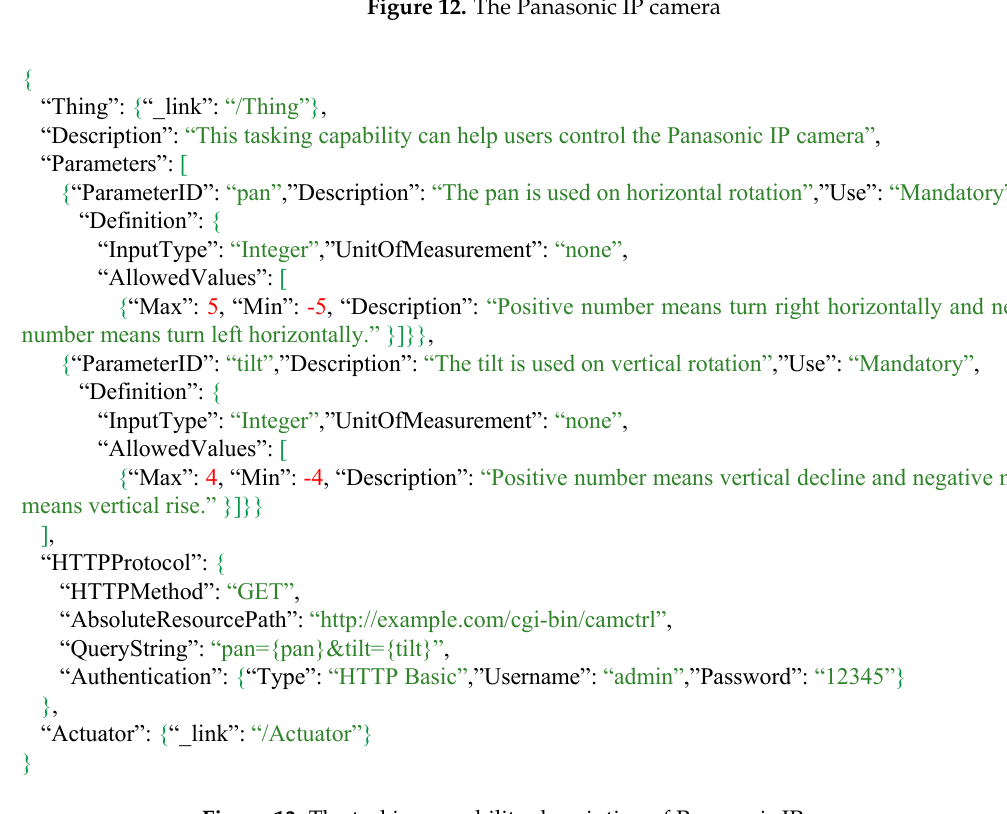
Figure 13. The tasking capability description of Panasonic IP camera.